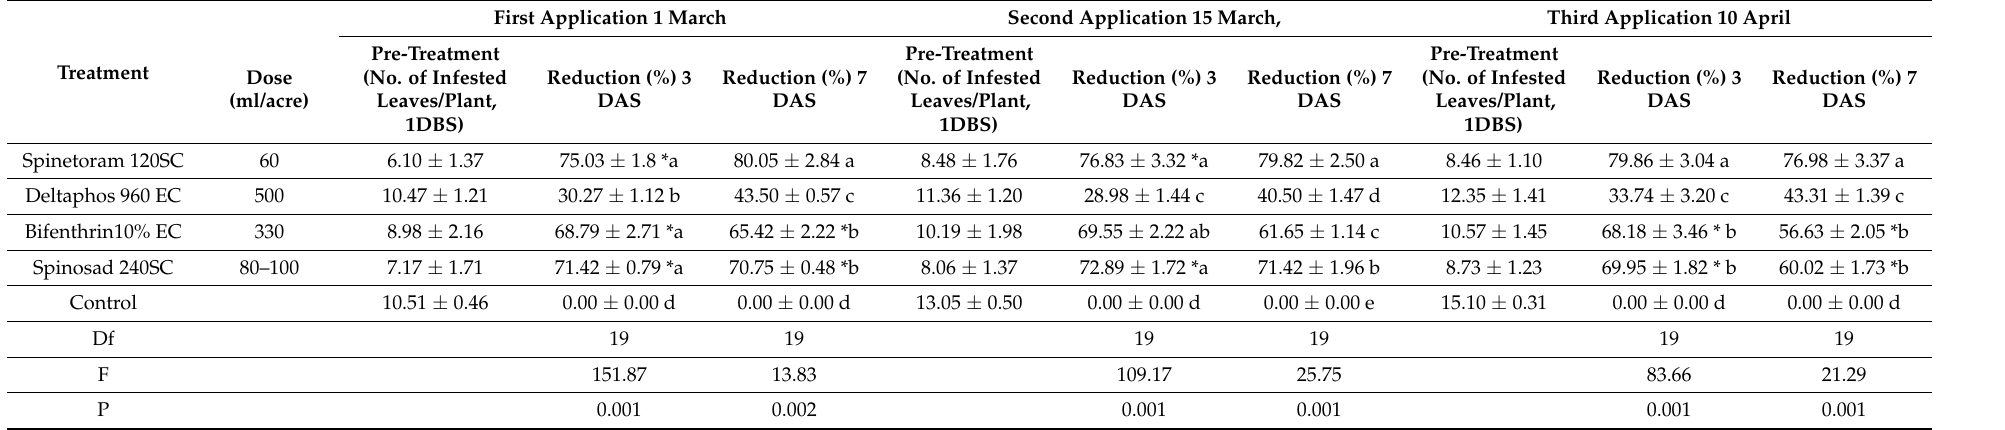
Table 5. Population reduction of tomato leaf miner after first, second and third spray of